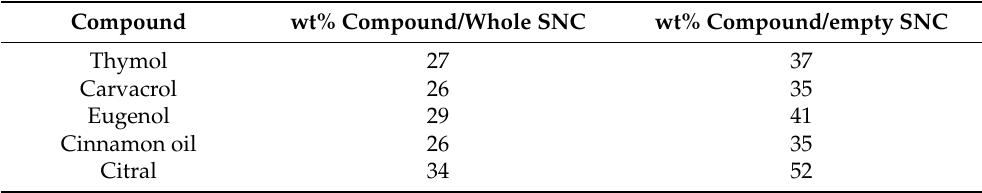
Table 1. Amount active compounds encapsulated in the silica nanocarriers (SNC) per whole mass of the loaded nanocarrier or per mass of empty